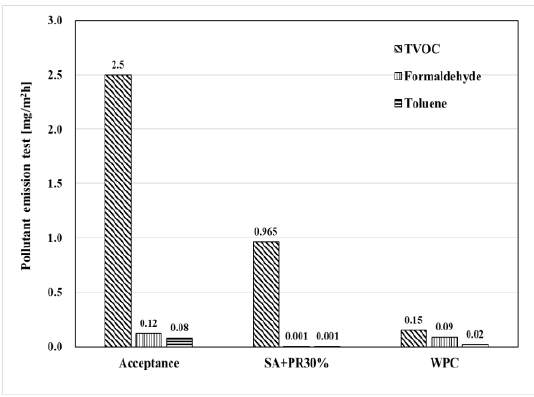
Figure 11. Pollutant emission result.